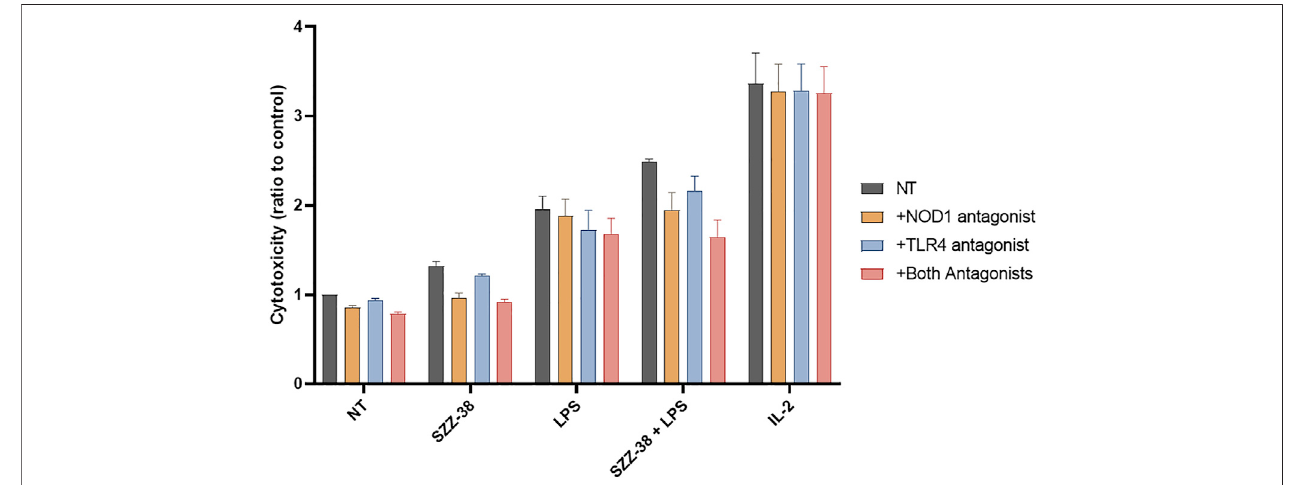
FIGURE 5 | Effect of NOD1 and TLR4 antagonist pre-treatment on the SZZ-38- and LPS-induced PBMC cytolytic activity against K562 cells. PBMCs were pre- treatedwiththeNOD1antagonistNodinitib-1(10 µM),TLR4antagonistTLR4-IN-C34(100 µM),orbothfor1 h,beforetheadditionofSZZ-38(1 µM),LPS(10 ng/mL),or IL-2 (200 IU/mL). Following 18 h activation, K562 cells were added. Cytotoxicity was determined after 4 h of co-incubation. Data are shown relative to the negative control (0.1 % DMSO) and expressed as means ± SEM of three independent experiments.